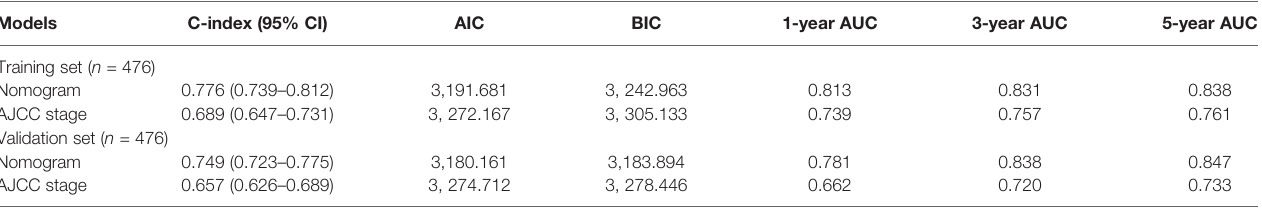
TABLE 2 | Comparison of prognostic performances between the constructed nomogram and the AJCC staging system.